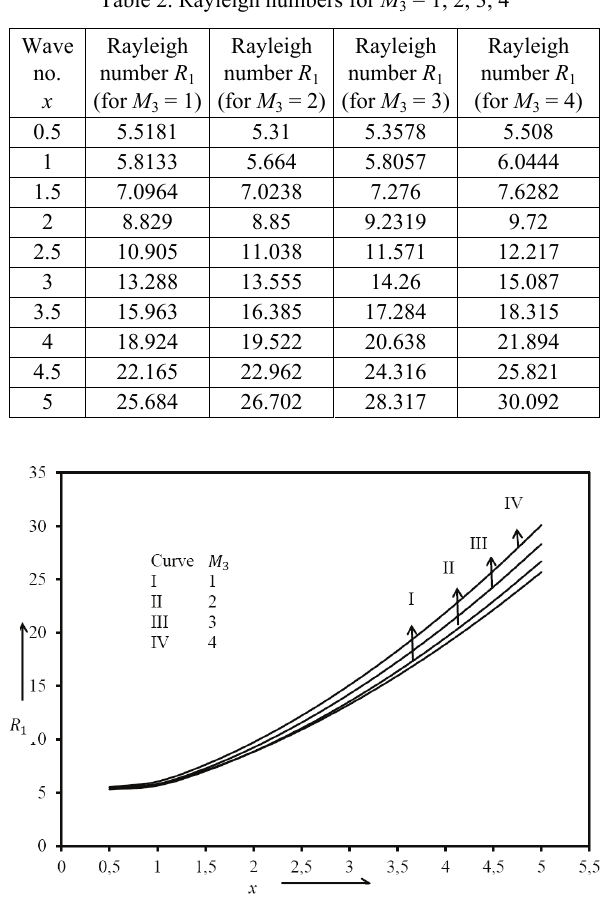
Fig. 3. Variation of Rayleigh number ( R 1 ), with wave number ( x ) for M 1 = 1,  = 0.09 and M 3 = 1, 2, 3, and 4 for curves I, II, III and IV, respectively